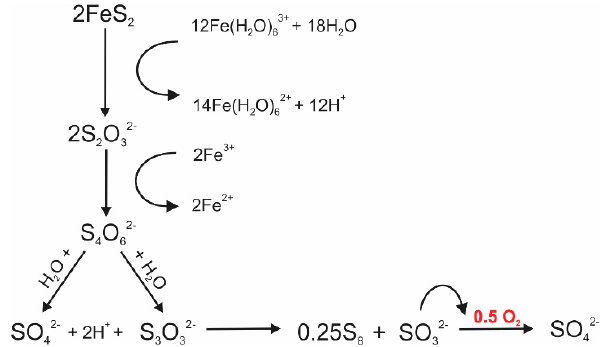
Figure 5. Pyrite oxidation pathway under oxygen-saturated conditions. Molecular oxygen — indicated in red — shows the incorporation of O 2 into sulfates. This oxidation step is considered to decrease the relative percent contribution of WDO to produced sulfate. Figure modified from Balci et al. [72].